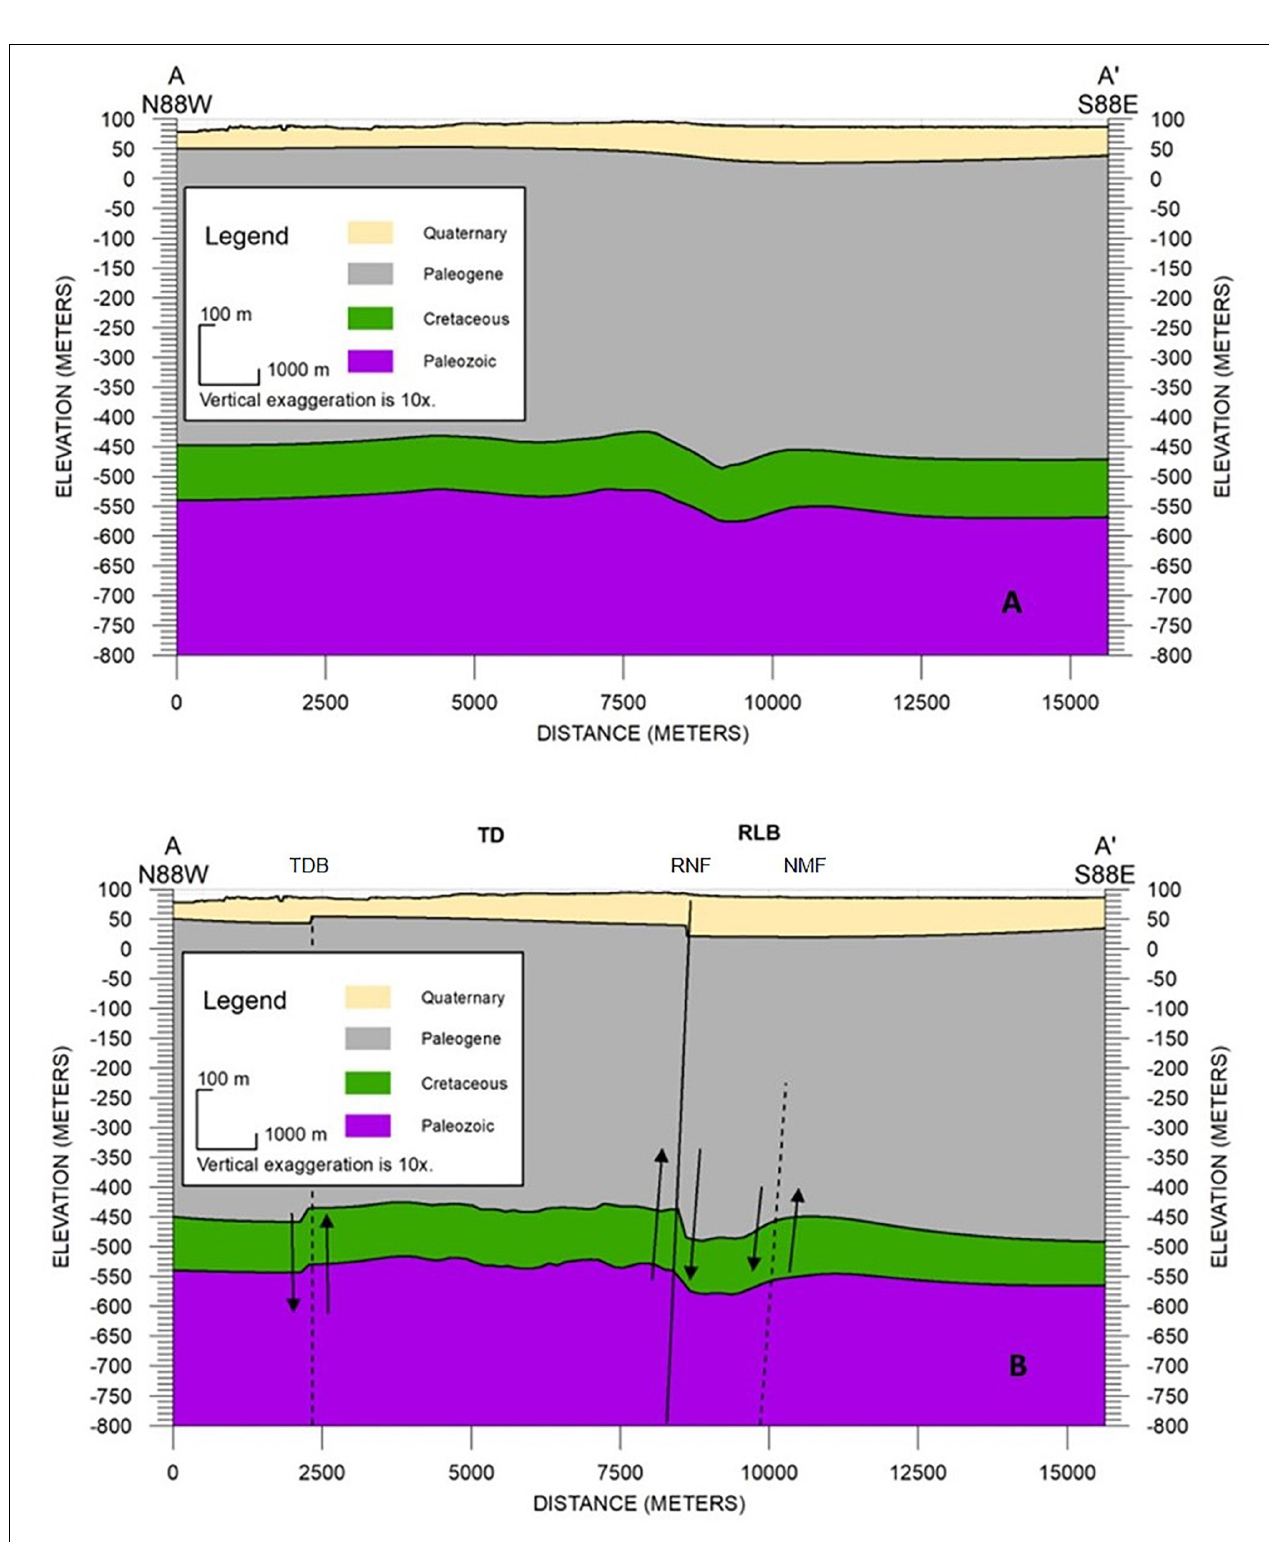
FIGURE 8 | (A) Cross-Section A-A’ (unfaulted) as located in Figure 3 shows the Quaternary alluvium (peach), Eocene (gray), Cretaceous (green), and Paleozoic (purple). (B) Faulted Cross-Section A-A’. TD, Tiptonville dome; RLB, Reelfoot Lake basin; TDB, Tiptonville dome back thrust fault; RNF, Reelfoot North fault; NMF, New Markham fault. Vertical exaggeration =